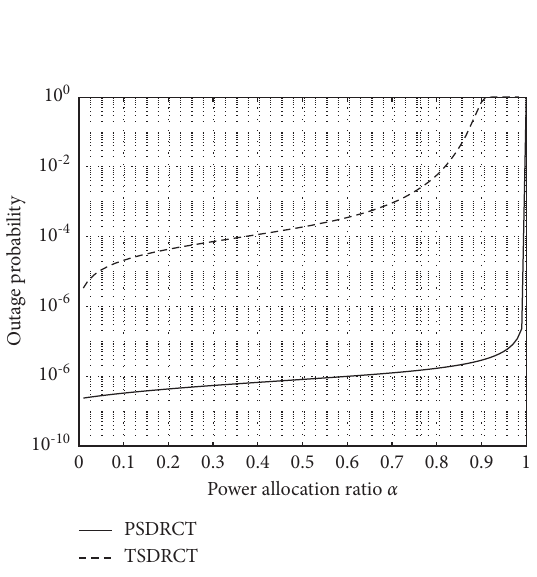
Figure 5: Outage probability against α .